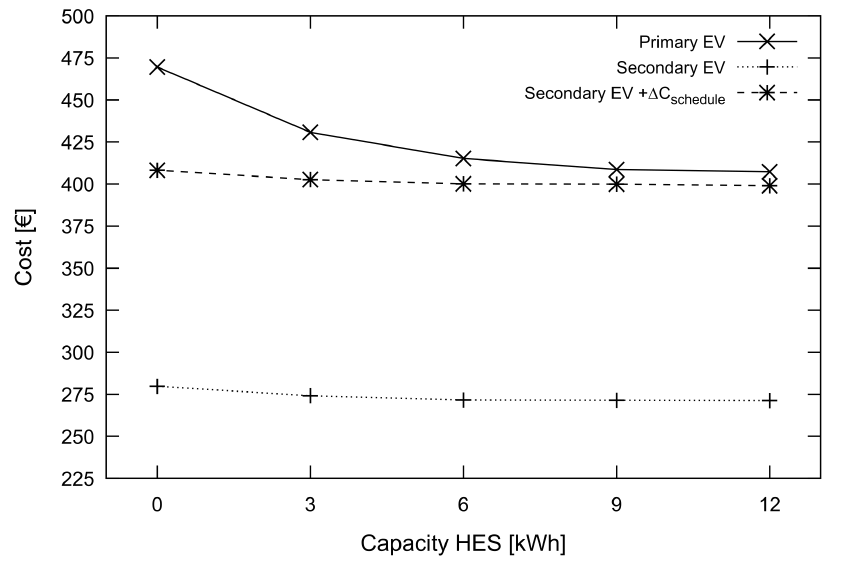
Figure 10. Total electricity cost gained from simulations and by applying the